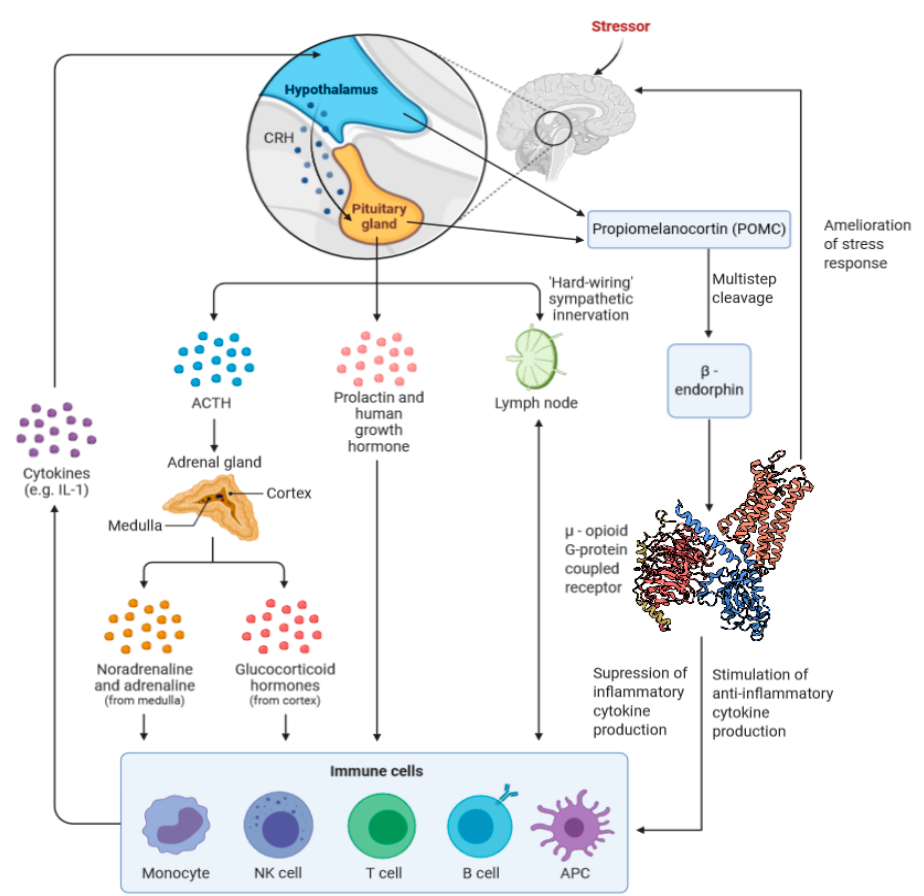
Figure 1. The interrelation between the hypothalamic–pituitary–adrenal (HPA), stress, and β -endorphins. β -Endorphins both attenuate the stress response and act to reduce levels of inflammatory cytokines, while increasing levels of anti-inflammatory cytokines, primarily through interaction with the mu-opioid receptor.